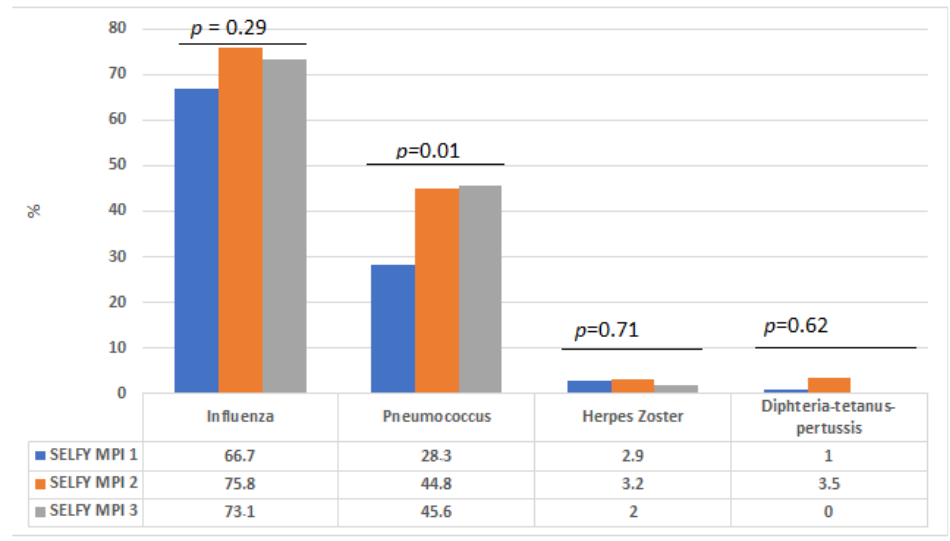
Figure 1. Vaccination coverage by SELFY-multidimensional prognostic index values.